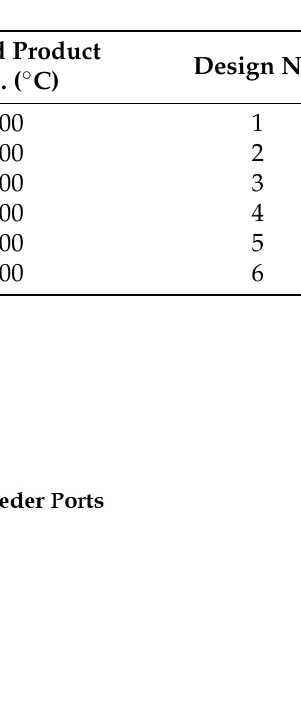
Figure 8. Distribution of the powder feeding ports on the roof of the reactor.